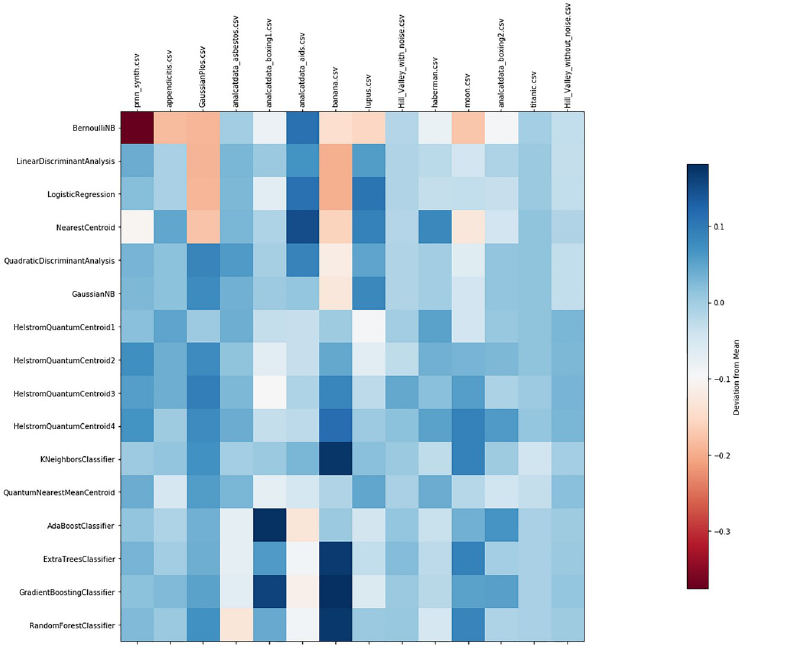
Fig 2. Deviation from the mean Balanced Accuracy across all 16